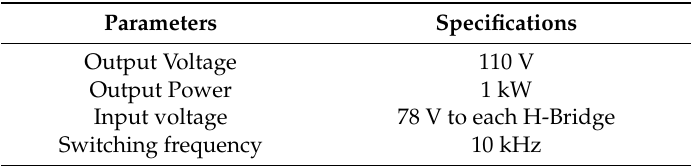
Table 1. System Design